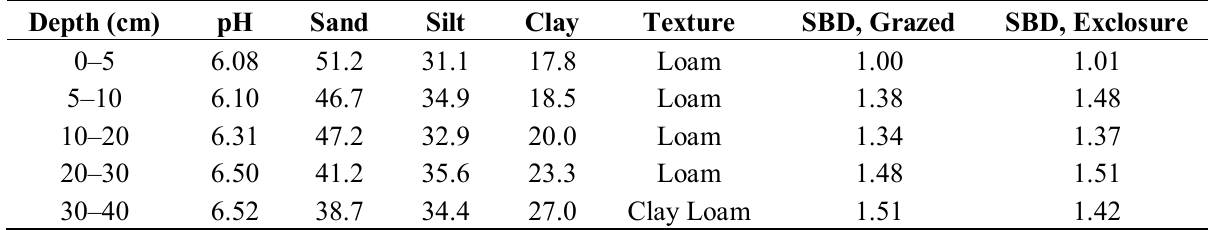
Table 1. Soil pH, particle size analysis, soil texture, and bulk density (SBD) in the established warm-season native grasslands from 0–40 cm soil depth. The SBD is recorded for both grazed areas and